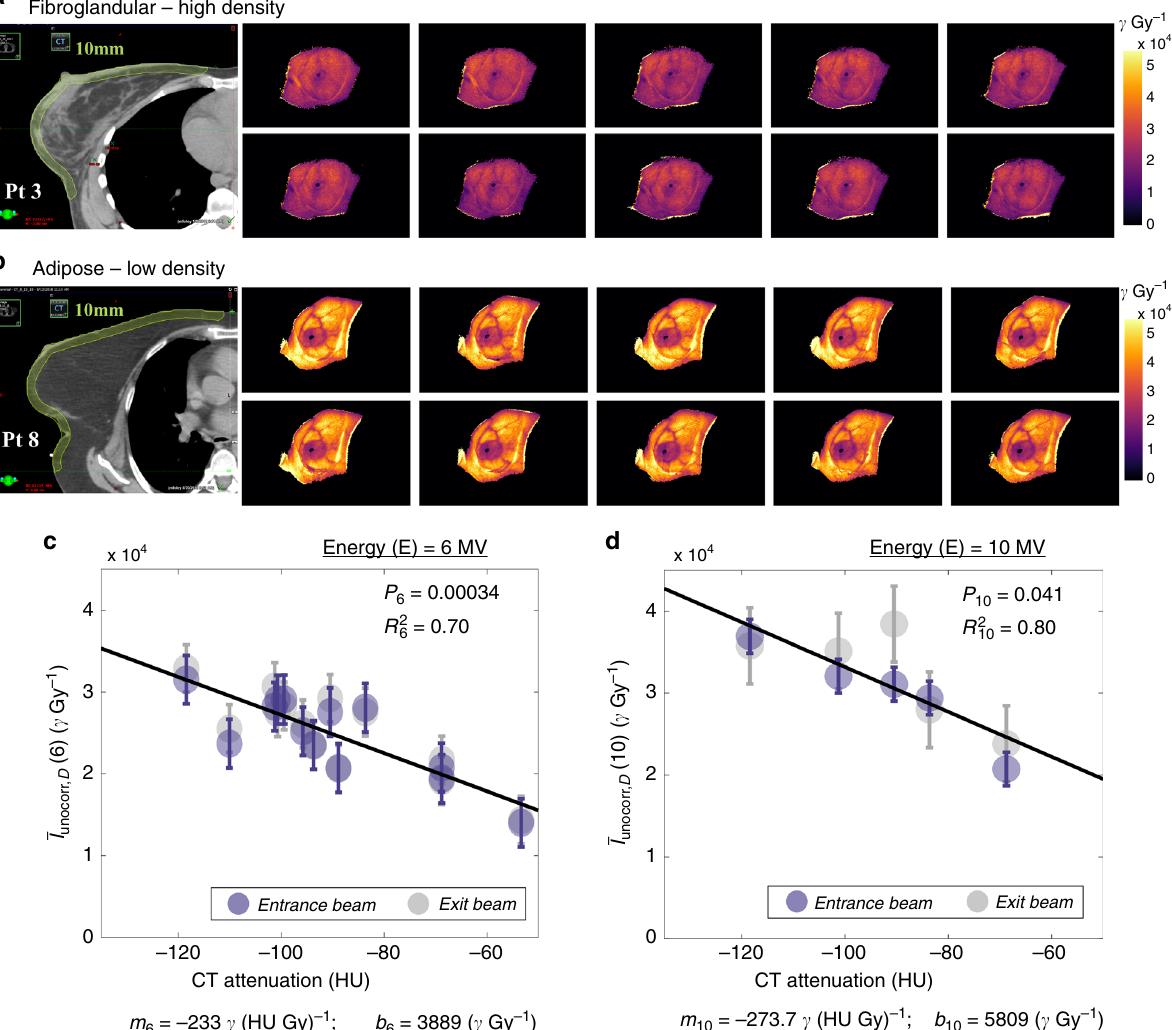
Fig. 4 Variability in Cherenkov intensity with fi broglandular and adipose tissue content. In a , the CT scan of Patient 3 shows dense, fi broglandular content throughout the breast volume. Ten fractions of Cherenkov imaging are pictured (units photons ( γ )), each normalized with respect to dose (Gy) as shown beside this. In ( b ), the CT scan of Pt 8 is characterized by largely adipose tissue, resulting in a much brighter appearance of Cherenkov images as compared those in a . Sub fi gures c and d illustrate the linear correlation between HU and the median Cherenkov counts per unit delivered dose ( γ Gy − 1 ), averaged over the number of fractions imaged (mean). Beams are separated by color (Entrance/RPO, gray and Exit/LAO, blue). Sub fi gure ( c ), n = 13, maps this relationship for all 13 patients treated with 6 MV beams, and ( d ), n = 5, for the fi ve patients treated with 10X beams. Each point shown is averaged over all fractions for each patient (see Table 1 for number of fractions). RPO and LAO means for each patient were averaged into one point, and the linear correction was computed and applied to each Cherenkov ( γ Gy − 1 ) value for both 6X and 10X beams to normalize the Cherenkov signal by HU value (Supplementary Fig. 2b, d). Error bars shown depict the root mean square